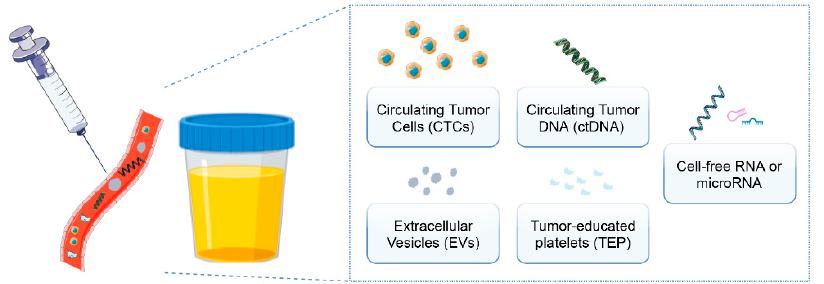
Figure 1. Clinical potential of liquid biopsies: what can we analyze using this promising non-invasive technique? Circulating tumor cells/DNA, extracellular vesicles, tumor-educated platelets and cell-free RNA or miRNA can be detected in the context of a liquid biopsy.